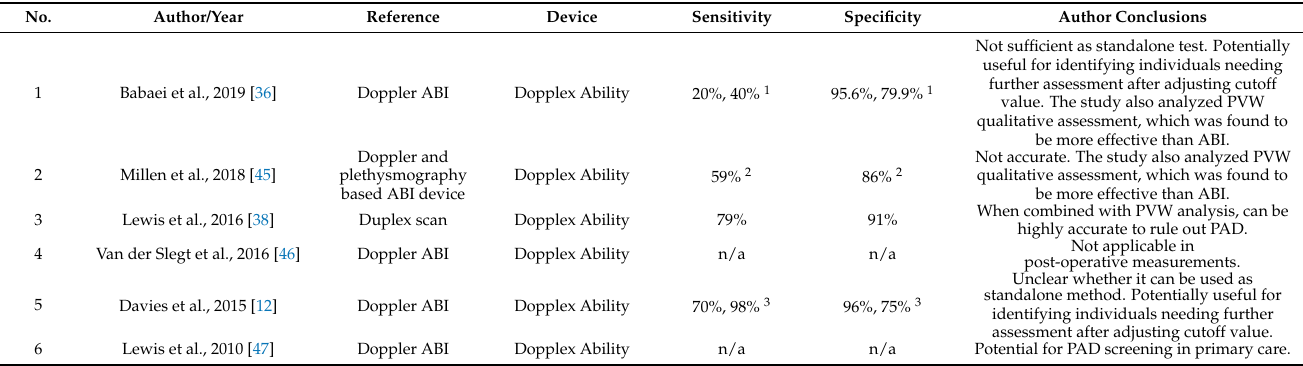
Table 3. Studies on air plethysmography ABI devices. Abbreviations: ABI—ankle-brachial index, PVW—pulse volume waveform, PAD—peripheral artery